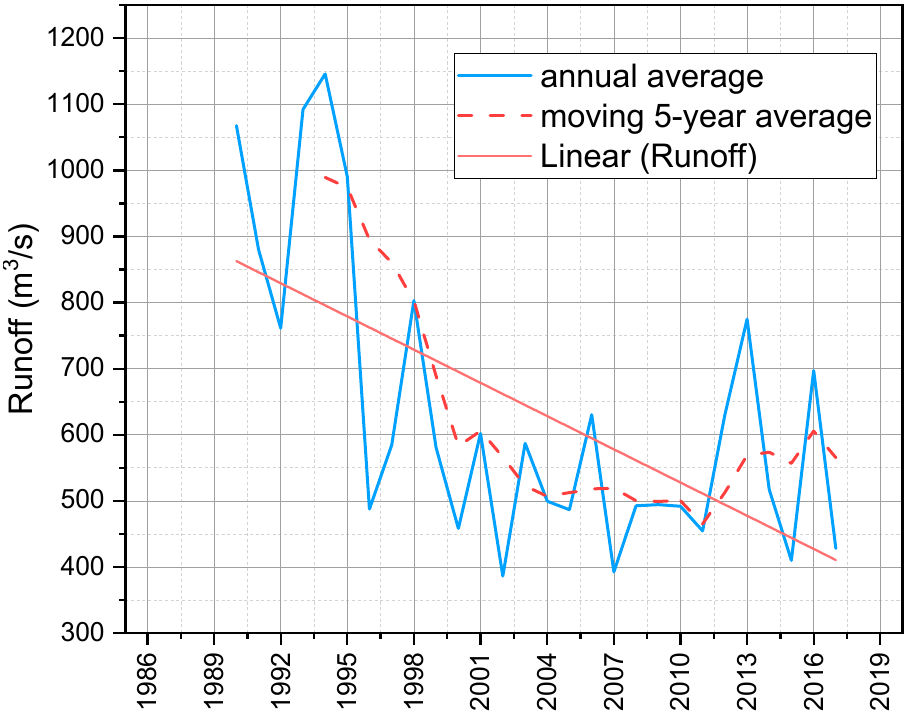
Figure 6. Runoff trend at the Novoselenginsk station for the period of 1990–2017.